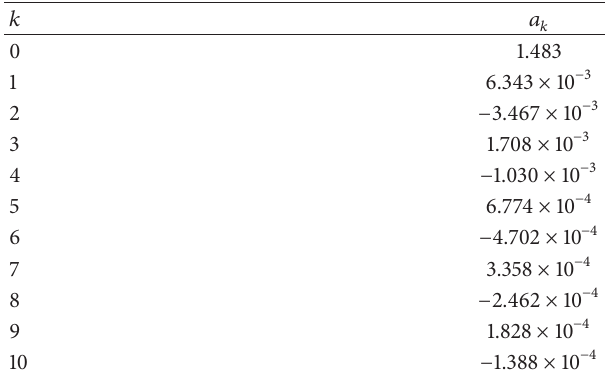
Figure 9: Refractive index distribution in time. Table 6: Fourier